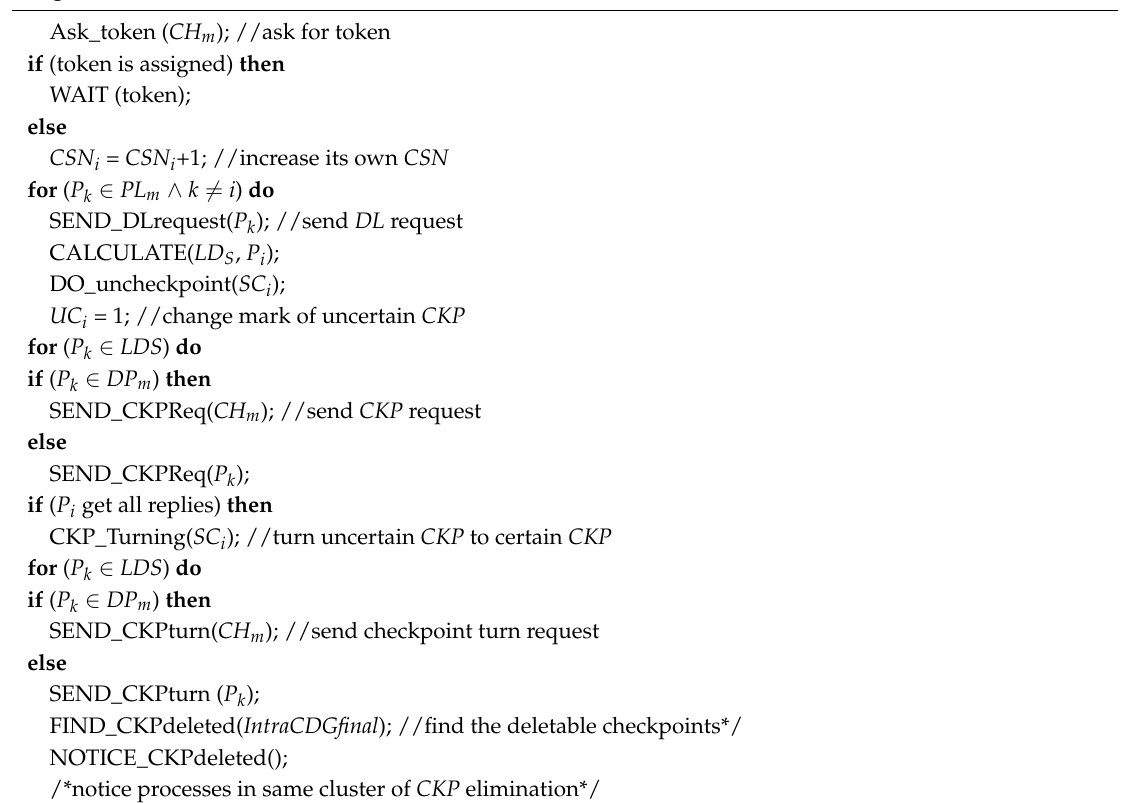
Algorithm 2 CKP_InitProcess(